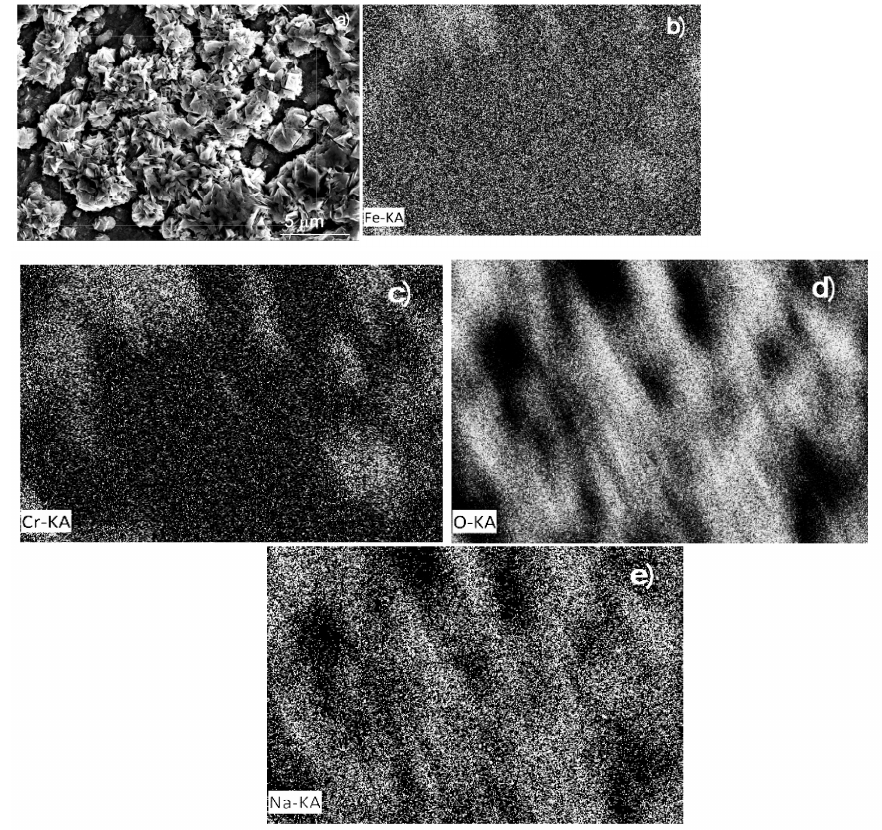
Figure 10. SEM micrograph of T91 steel corroded in 60 wt% NaNO 3 at 500 °C showing ( a ) secondary electrons image and EDX mappings of ( b ) Fe, ( c ) Cr, ( d ) O and ( e ) Na.